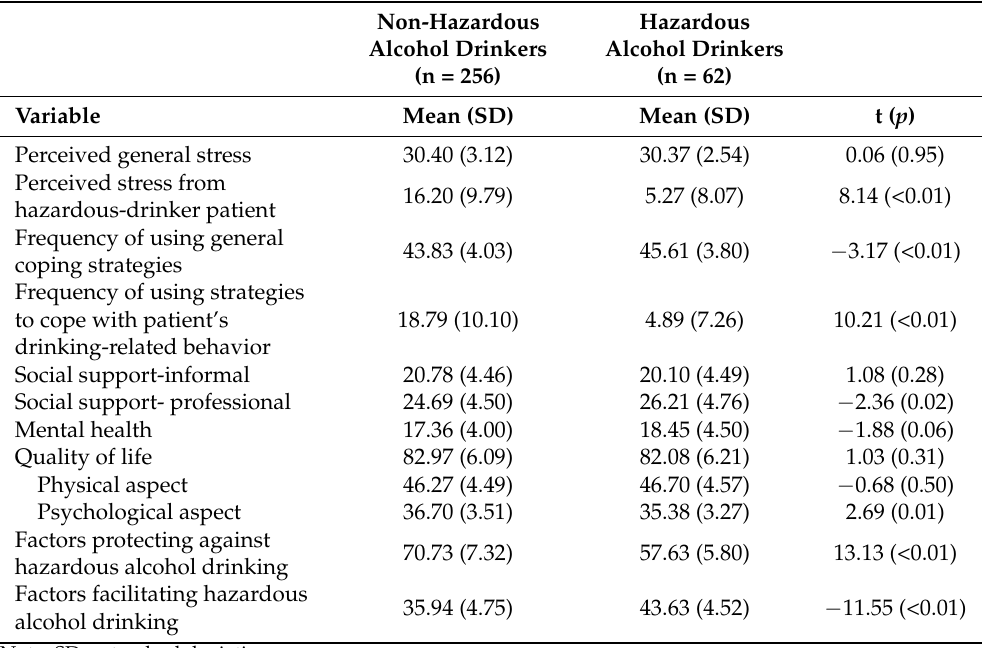
Table 2. Factors related to family members without and with hazardous alcohol-drinking behaviors (N =